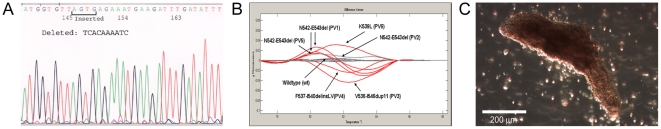
Identification of JAK2 exon 12 mutations.A: Sequence of F537-I540delinsLV mutation of PV4 revealing a 10 base-pair deletion and a four base-pair insertion. B: Difference plot of high resolution melting (HRM) analysis detecting N542-E543del, F537-I540delinsLV and K539L JAK2 exon 12 mutations in PV1, PV3, PV4, PV5 and PV6. C: Phase-contrast microphotograph showing Epo-independent growth of endogenous erythroid colonies (EEC) at day 14 of culture. Scalebar: 200 µm. HRM, high resolution melting.